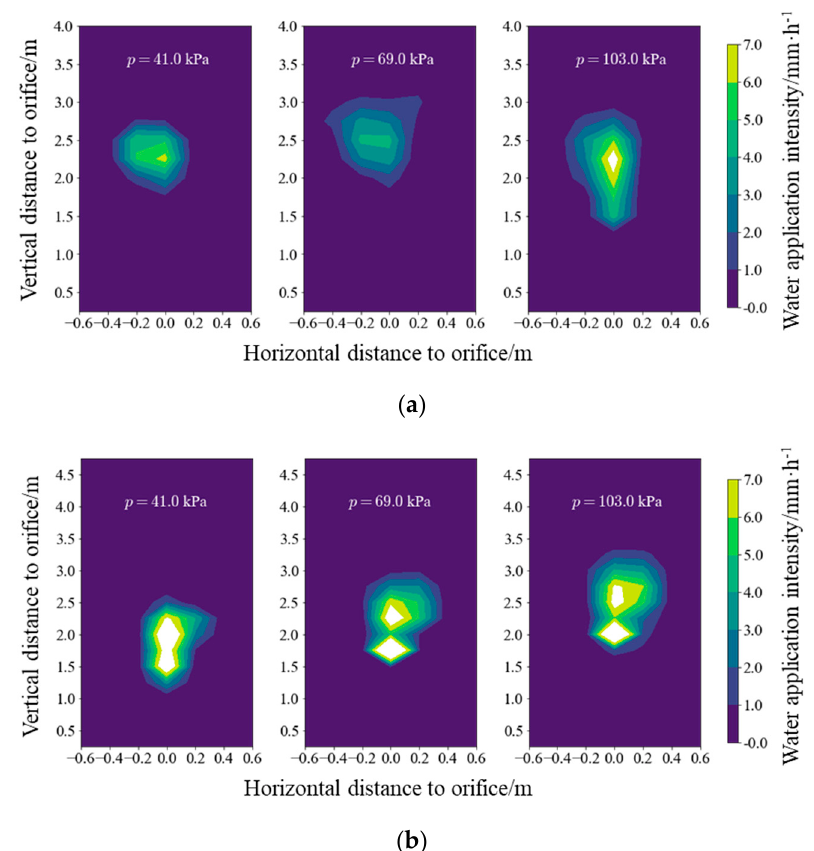
Figure 9. The measured value of water application intensity distribution under different orifice areas: ( a ) the individual orifice a 3-5 ; and ( b ) the individual orifice a 3-8.